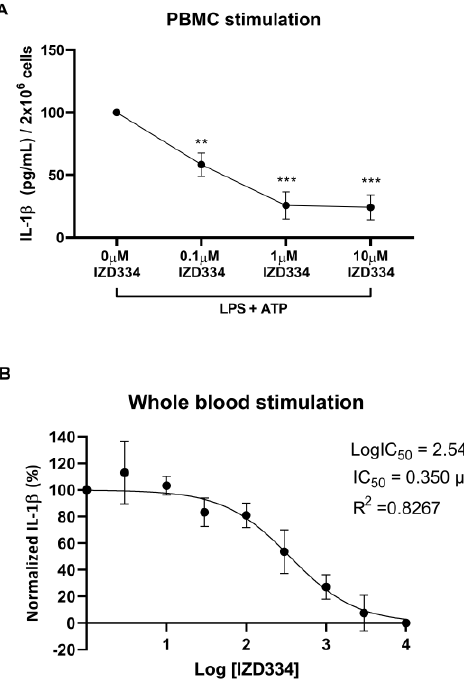
Figure 1. In vitro reduction of IL- 1β secretion. ( A ) Porcine peripheral blood mononuclear cells